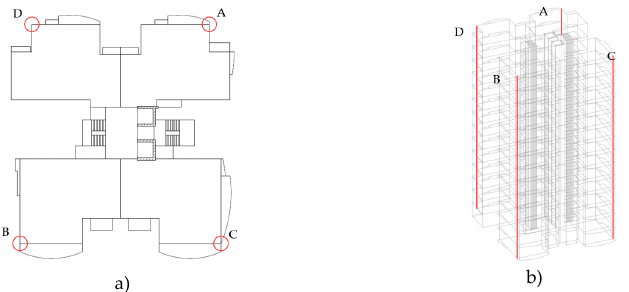
Figure 14. Linear elastic dynamic analysis: vertical alignments under study ( a ) plan view; ( b ) 3D view.